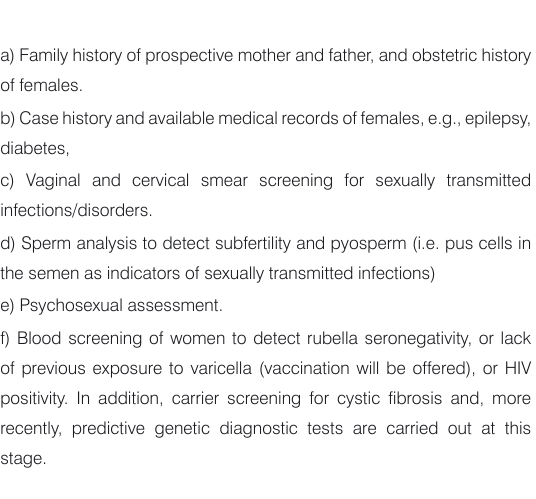
Table 1. The three stages of the Hungarian Preconceptional Care, and activities undertaken at each